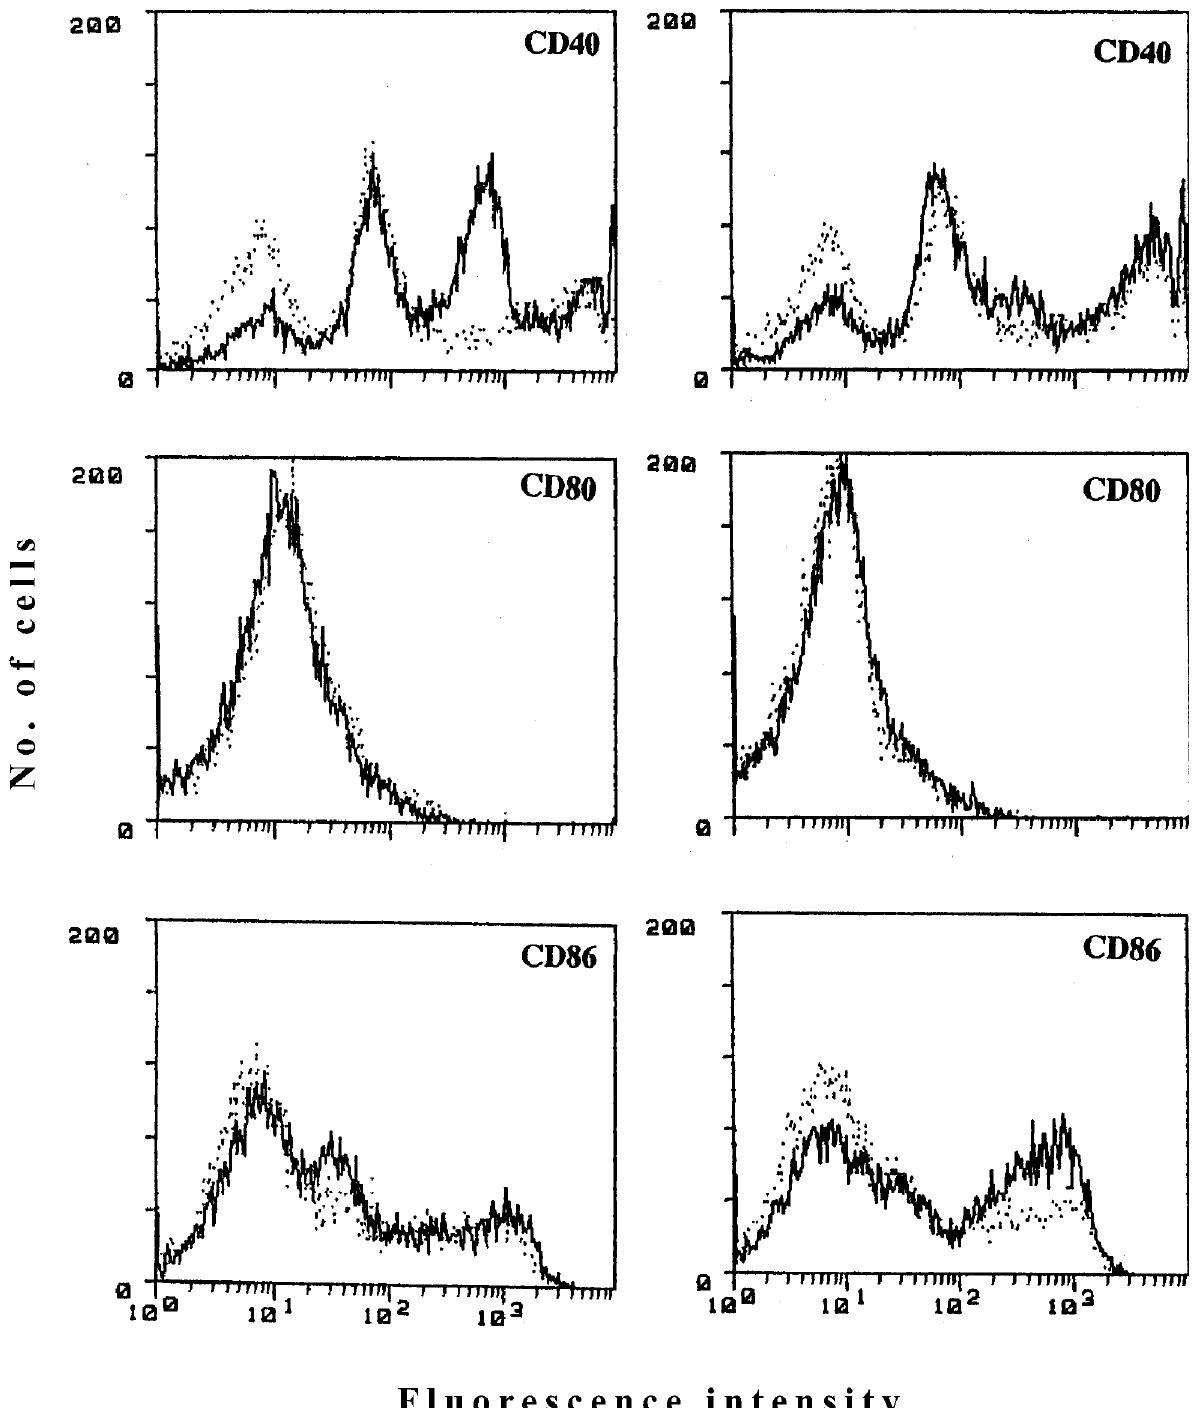
FIG. 1. Suppressive effect of IPD-1151T on co-stimulatory molecule expression on splenocytes obtained from BALB/c mice with allergic disorders. BALB/c mice were immunized intraperitoneally with two doses of 5.0 m g/ml of dinitrophenylated ovalbumin absorbed on 4mg of Al(OH) 3 at 1-week intervals. The mice were treated intraperitoneally with 100 m g/kg of IPD-1151T for 14 days, starting after the first immunization. Splenocytes were obtained from mice 24h after the challenge with the same dose of antigen, and assayed for co-stimulatory molecule expressions. [––––––], Saline-treated control mice; [– – – –], IPD- 1151T-treated mice. Left-hand side, Non-challenged mice; right-hand side, challenged